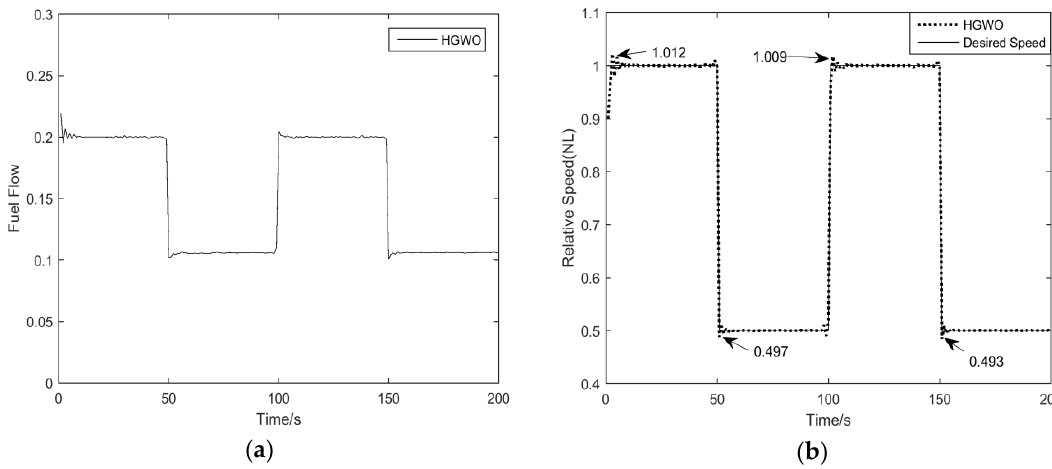
Figure 11. The simulation results of NMPC based on HGWO. ( a ) Fuel flow curve; ( b ) relative speed curve.